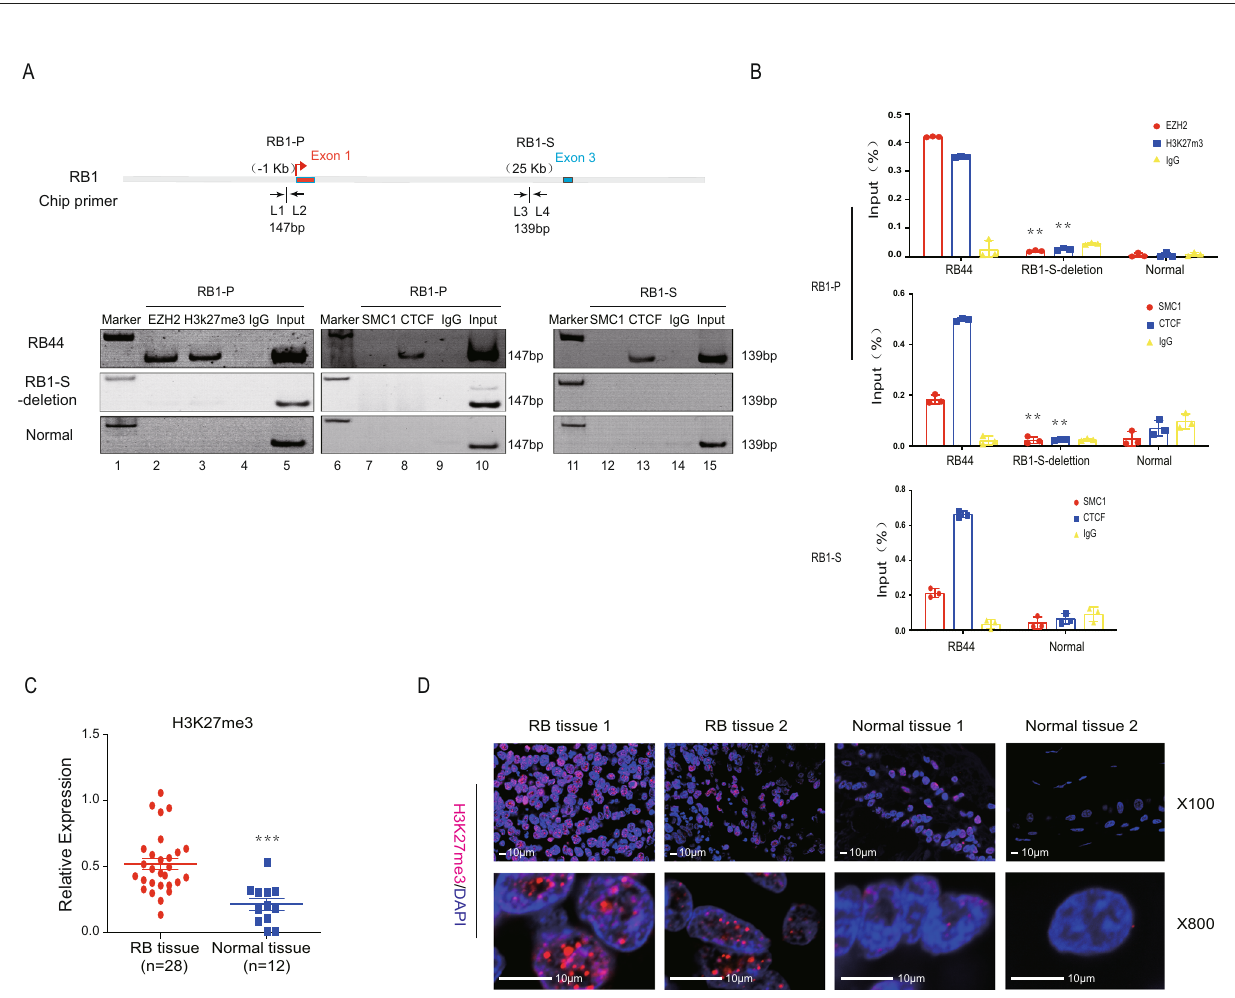
Fig. 3 CTCF-PRC2 complex is involved in the chromosomal looping at RB1 locus. A Top: Schematic of the ChIP site. L1-L4: primers in RB1 promoter region and RB1 suppressor region. Bottom: ChIP assay of the EZH2, H3K27me3, CTCF, and SMC1 status in the RB1 promoter region and the RB1 suppressor region. Normal: RPE cells. B The quanti fi ed ChIP was further con fi rmed by the above results. ** P < 0.01. C H3K27me3 expression in retinoblastoma tissues ( n = 28) compared with normal eye tissues ( n = 12). *** P < 0.001. D Immuno fl uorescence assays were performed with H3K27me3 probes in retinoblastoma tissues and normal tissues. Scale bars: 10 µ